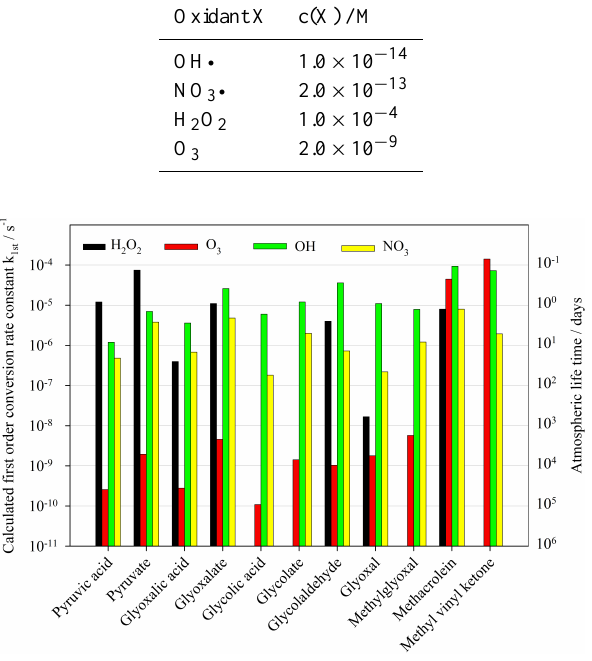
Fig. 6. Intercomparison of the calculated first-order conversion rate constants k 1st [s − 1 ] from reactions with H 2 O 2 , O 3 OH with the investigated carboxylic acids, aldehydes and unsaturated compounds for an urban cloud